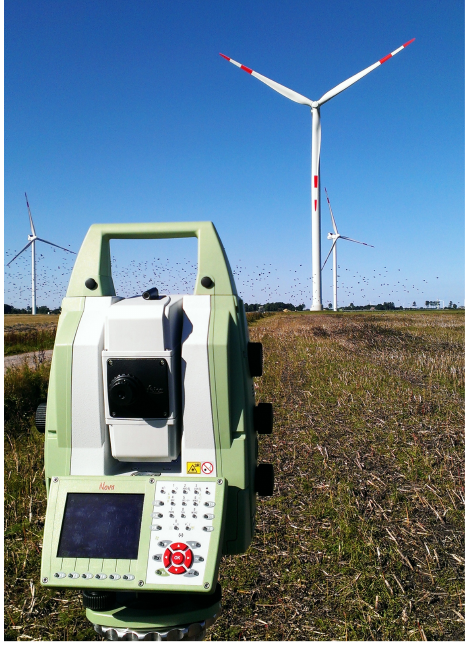
Figure 1. Measurement setup: tachymeter and turbine at a stand-